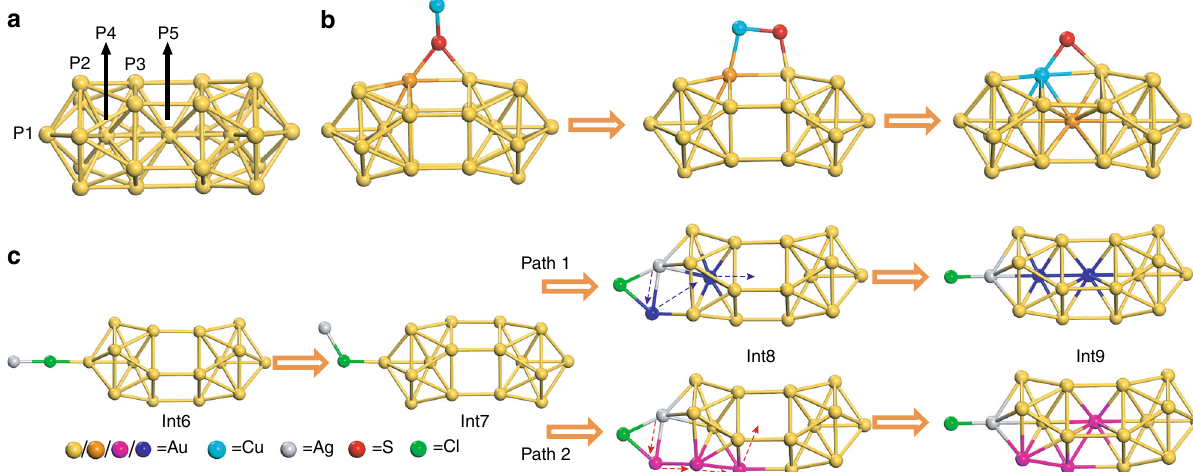
Fig. 5 Mechanisms for the formation of doped MAu 24 clusters based on DFT calculations. a Designation of sites P1 – P5 in the Au 25 structure. DFT- calculated mechanisms for MAu 24 (M = Cu or Ag) formation with M at b waist and c apex positions. Color code: Au, yellow; S, red; Cl, green; Cu, cyan; Ag, gray. Note, in b , a gold atom at the waist position that is pushed into the vacancy to form CuAu 24 is shown in orange. In c , to show two different pathways, i.e., paths 1 and 2, corresponding gold atoms are either presented in dark blue or magenta. Only one Cl and S of the nanoparticle is presented. Other atoms and bonds are not shown for